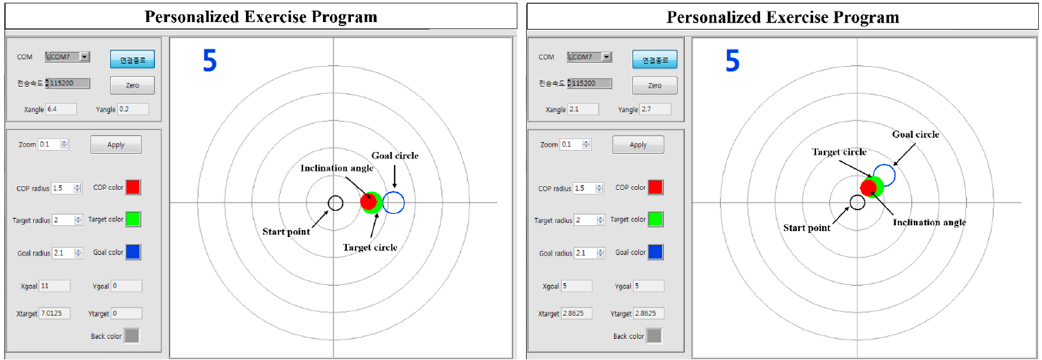
Figure 4. Lateral pelvic tilt and lateral and anterior pelvic tilt exercise.